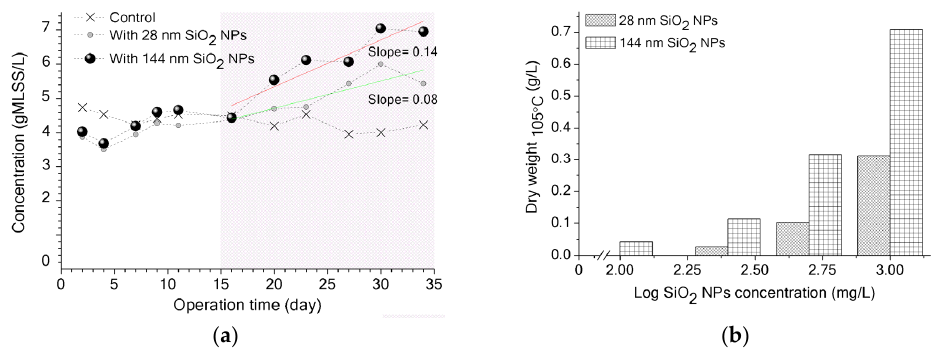
Figure 2. Effect of SiO 2 NPs on the evolution of MLSS during ( a ) a continuous experiment in a membrane bioreactor (MBR) and ( b ) batch experiment with pure SiO 2 NPs. The shaded area indicates exposure to SiO 2 NPs. exposure to SiO 2 NPs.